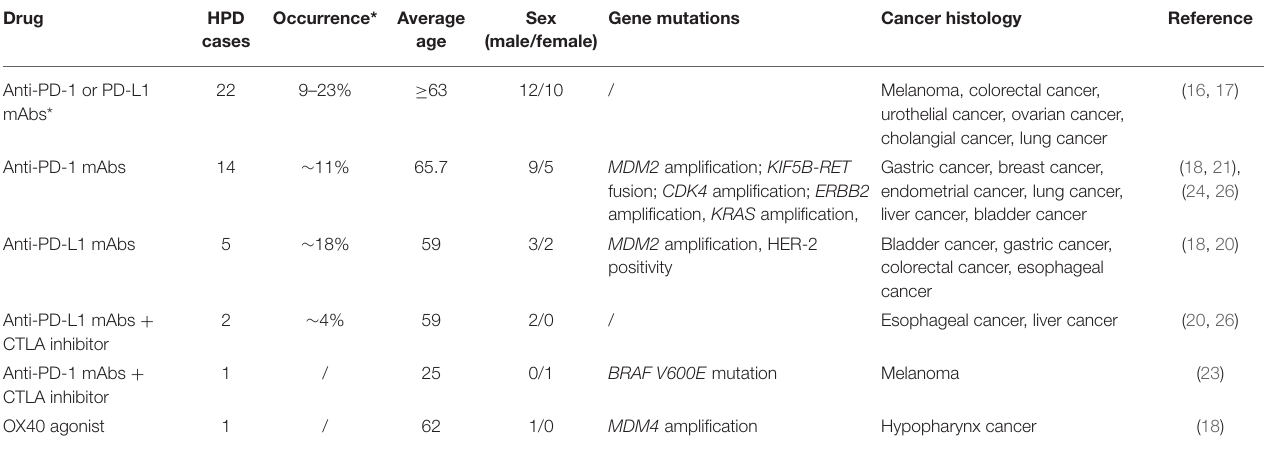
TABLE 2 | Characteristics of HPD Cases.